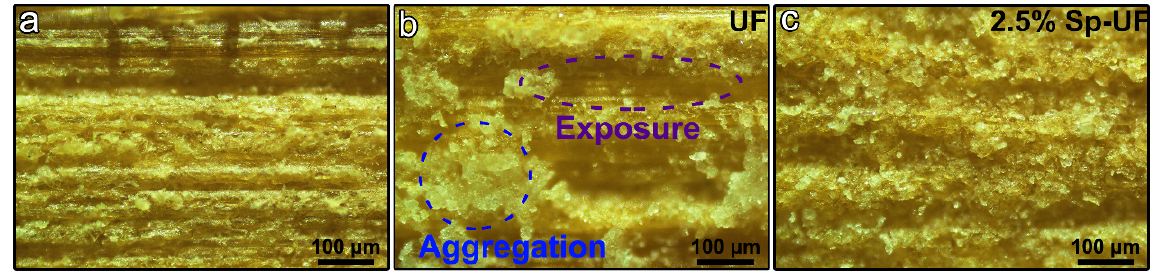
Figure 8. Optical microscopy images of ( a ) unglued bamboo veneer and glued bamboo veneers with cured ( b ) UF resin and ( c ) 2.5% Sp-UF resin at the glue spread of 60 g m –2 .